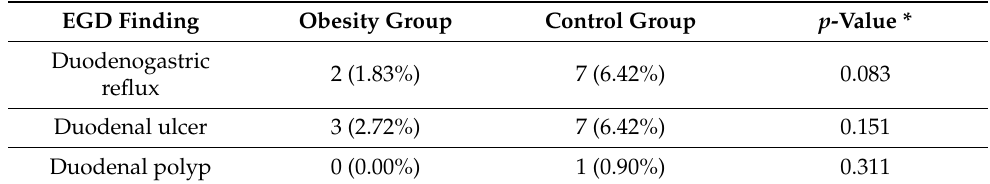
Table 4. Duodenal pathologies found using EGD in the study groups.